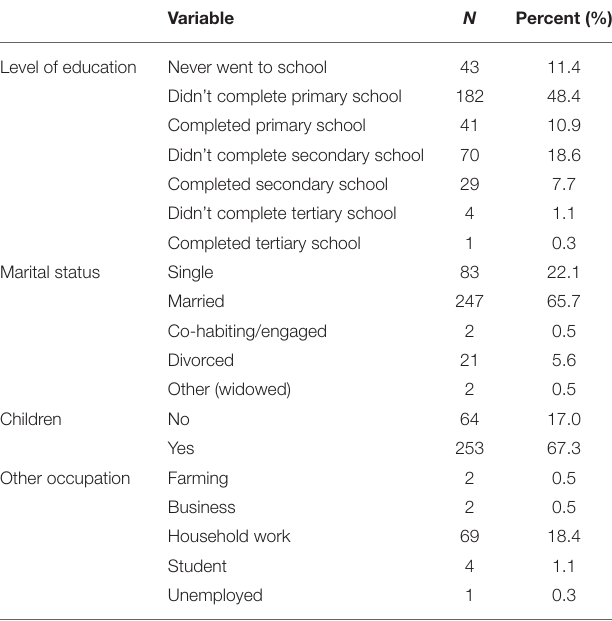
TABLE 2 | Additional demographic information of the study participants. Variable